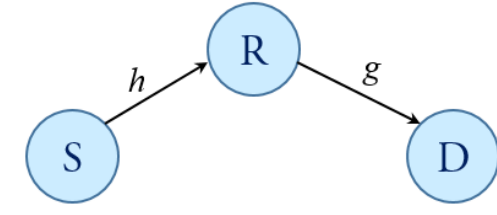
Fig. 1: System Model.